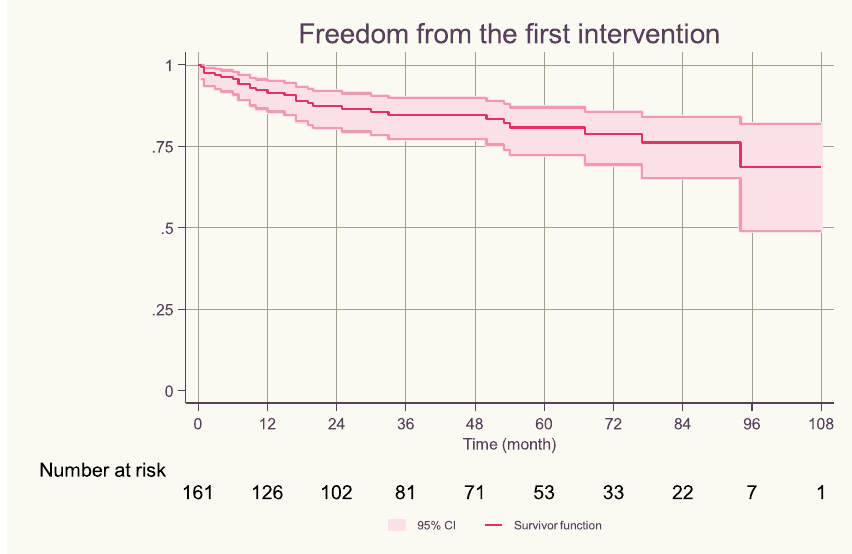
Fig. 1 Freedom from reinterventions after tetralogy of Fallot